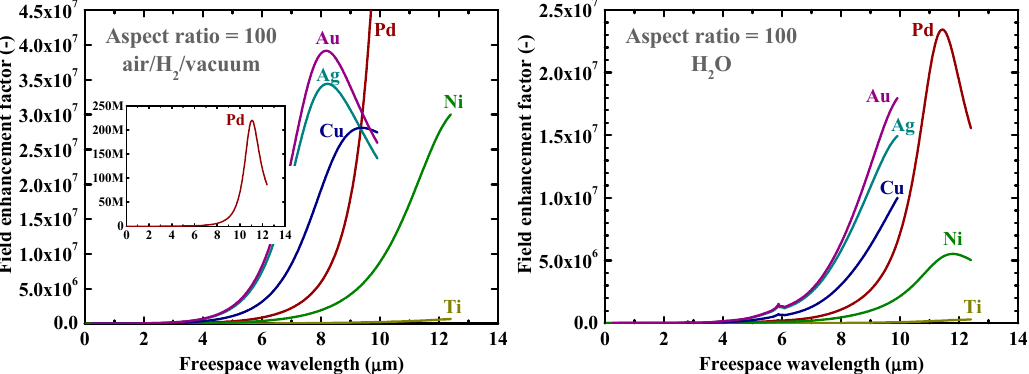
Figure 4. Calculated electromagnetic field enhancement factors at the tips of spheroidal nanoparticles of Au, Ag, Cu, Pd, Ti, and Ni with an aspect ratio of 10 in ( left ) air/H 2 /vacuum and ( right ) H 2 O. The insets are the clarified plots for Au, Ag, and Cu. Nanomaterials 2019 , 9 , x FOR PEER REVIEW